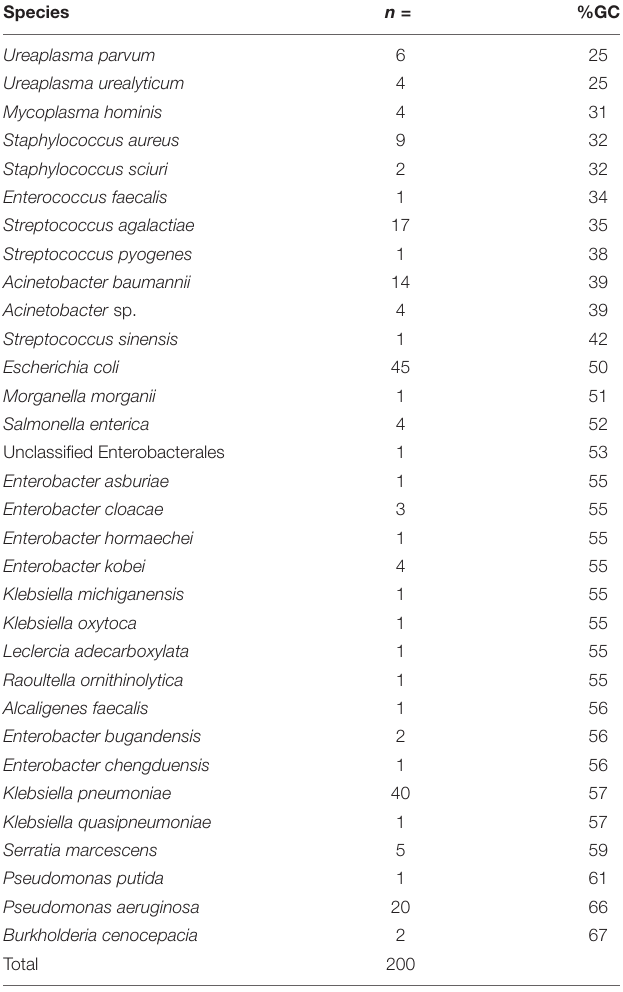
TABLE 1 | The bacterial species included in the dataset for analysis ( n = 32 different species), the number of each species, and the approximate %GC content based on the (original basecalled de novo hybrid